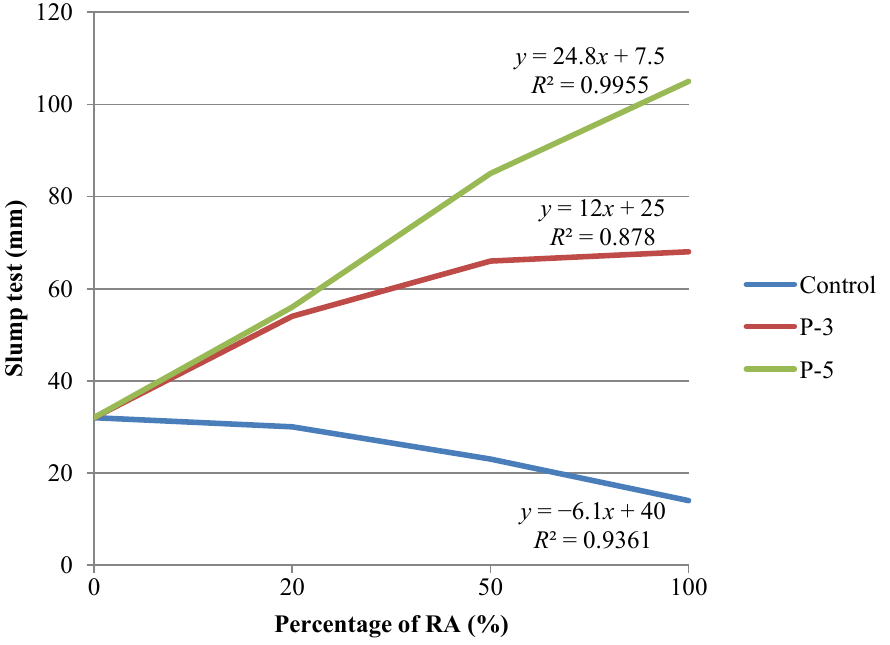
Figure 5. Slump test results for each concrete mix replacement and pre-saturation